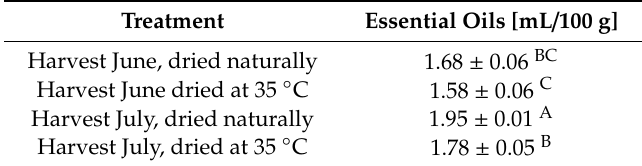
Table 2. E ff ect of harvest period and drying method on essential oils content of sage